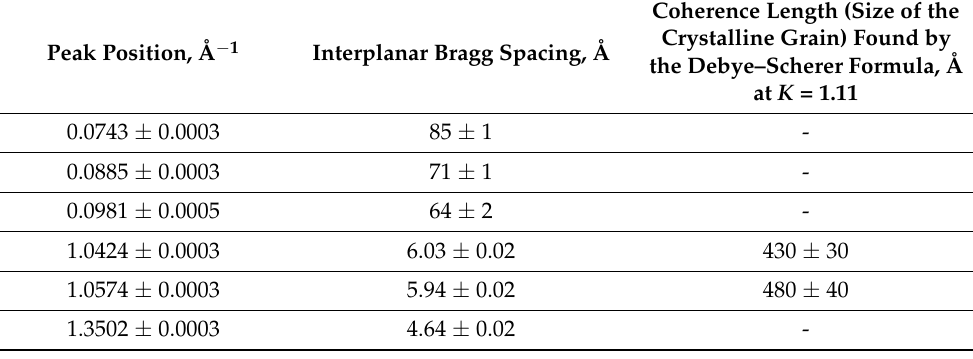
Table 1. Parameters of leading diffraction peaks of crystallite systems. The crystalline sizes for low-resolution wide-angle diffractometry are not presented due to instrumental broadening. Peak Position, Å − 1 Interplanar Bragg Spacing, Å